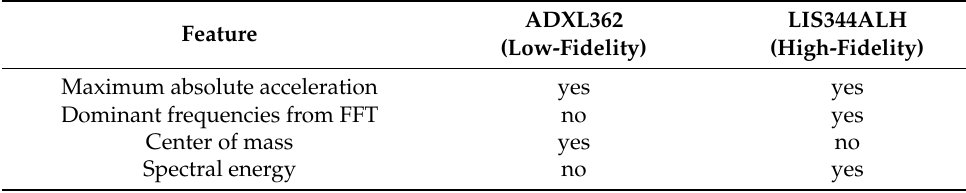
Table 1. Inputs for ANN